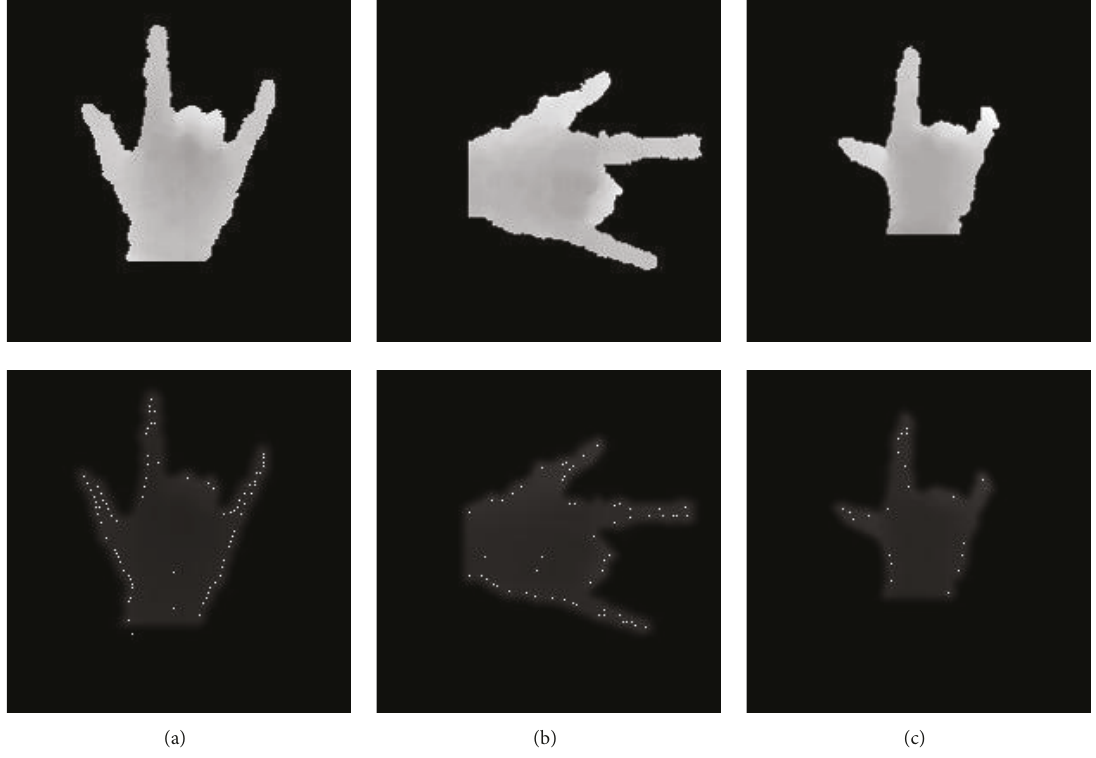
Figure 8: SIFT features are robust to orientation changes (b) and scale changes (c) along with normal pose